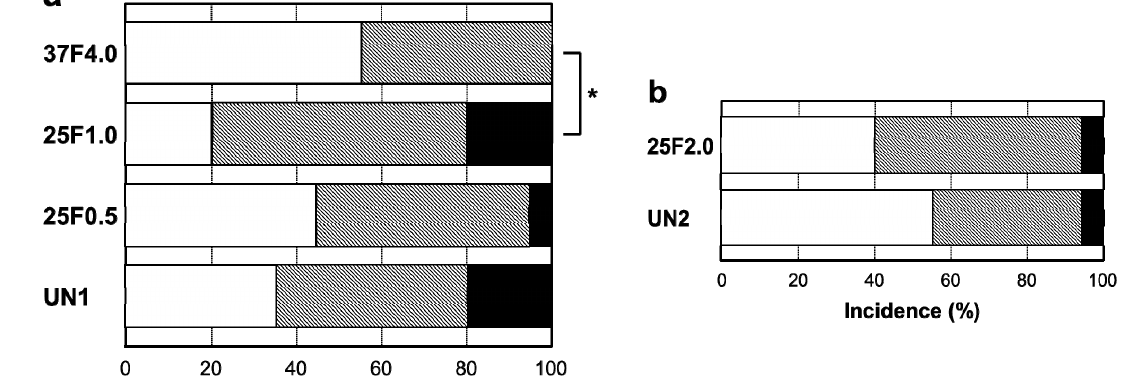
Figure 7. Percent incidence of Grades 0v, 1v, and 2v pin tract infections determined by visual inspection of the ( a ) UN1, 25F0.5, 25F1.0, and 37F4.0 groups; and for the ( b ) UN2 and 25F2.0